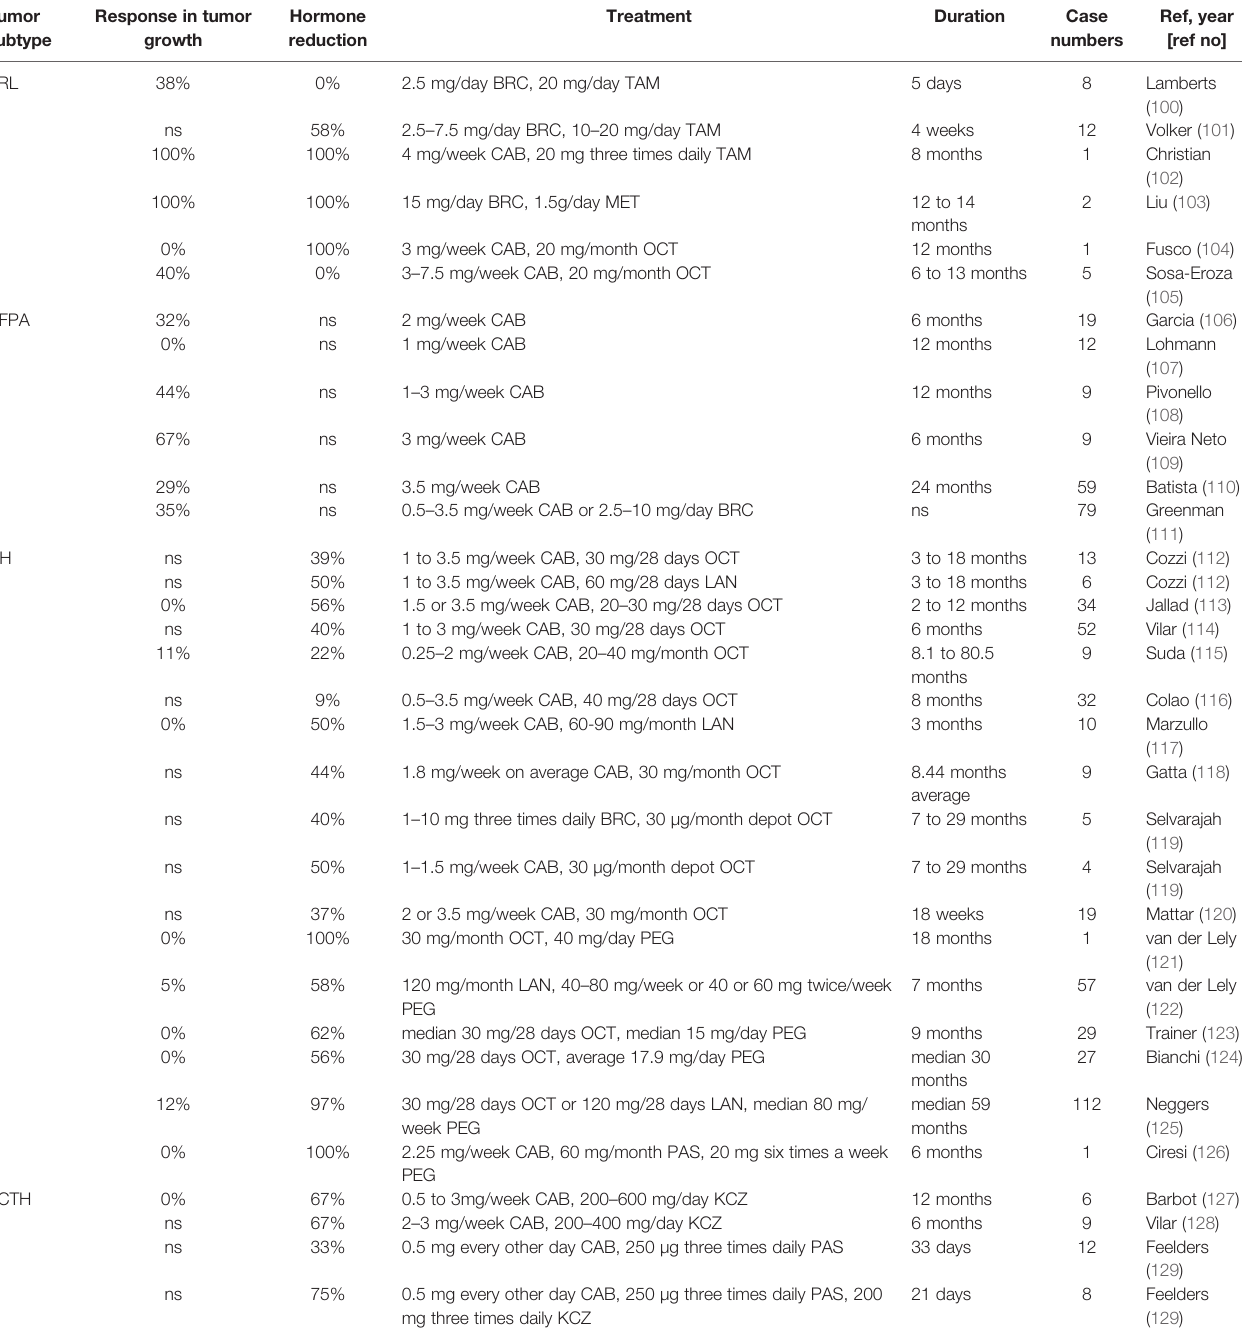
TABLE 6 | Summary of conventional therapies for aggressive prolactinomas, Cushing ’ s disease, and acromegaly and non-functional pituitary adenomas. Tumor Response in tumor subtype